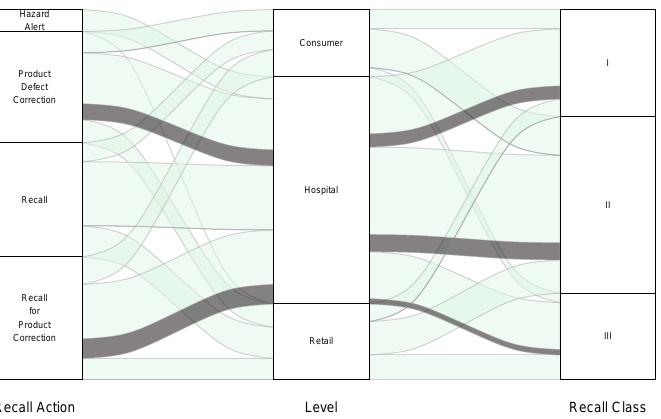
Figure 4. Alluvial diagram of recalls types, levels, and recall class in the SARA dataset. Data are plotted for SaMD and all other medical devices (Non-SaMD). The scale is